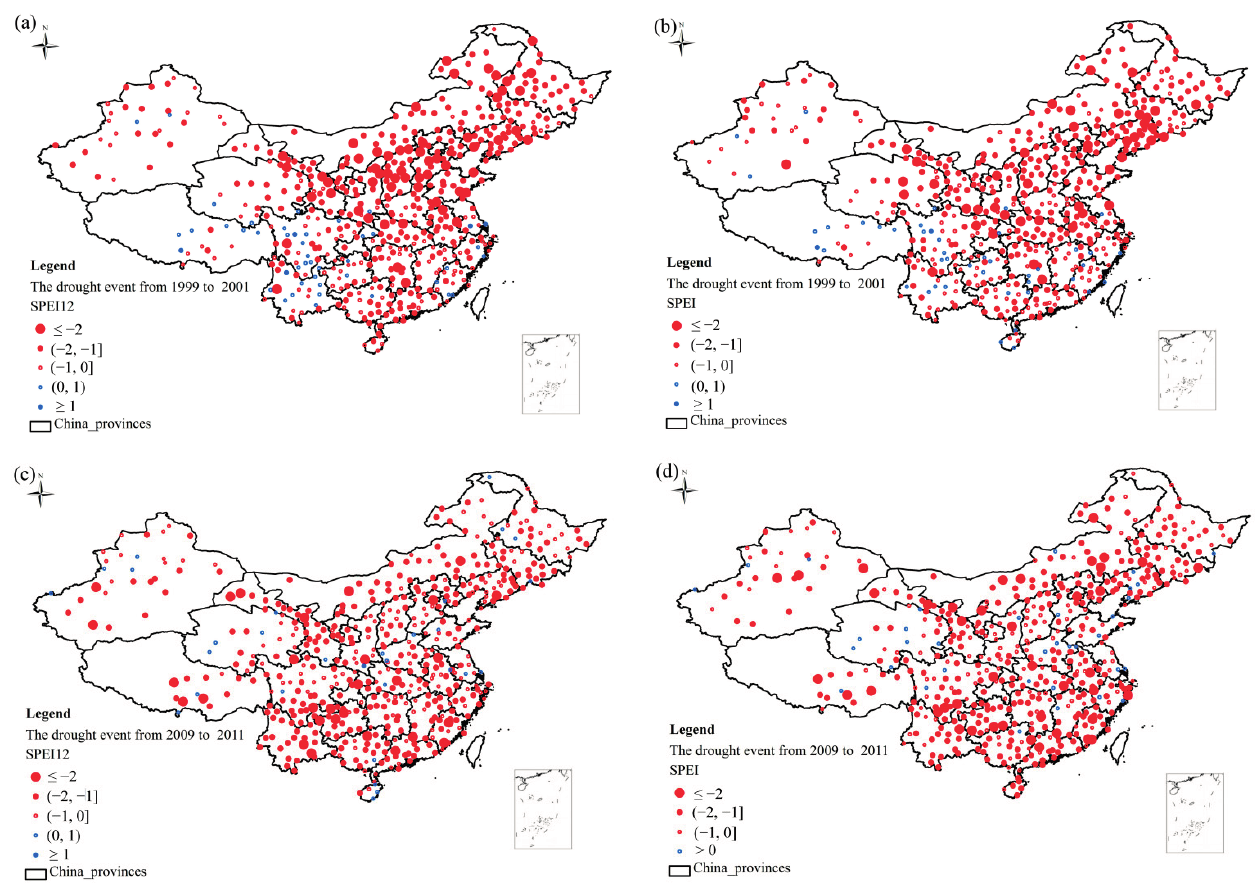
Figure 4. ( a ) The spatial distribution of large-scale drought events from 1999 to 2001 based on the SPEI-12; ( b ) The spatial distribution of large-scale drought events from 1999 to 2001 based on the SPEI opt ; ( c ) The spatial distribution of large-scale drought events from 2009 to 2011 based on the SPEI-12; ( d ) The spatial distribution of large-scale drought events from 2009 to 2011 based on the SPEI opt